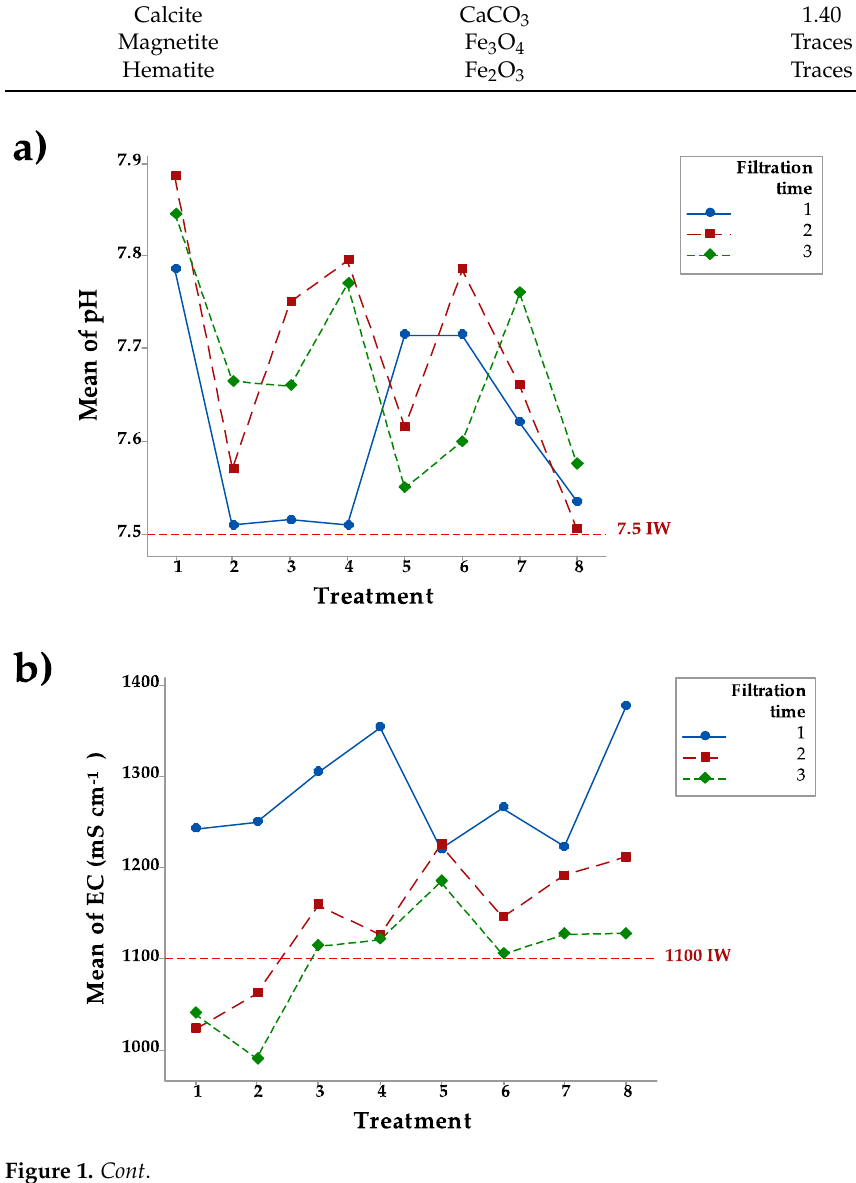
Figure 1. Levels of pH ( a ), EC ( b ), and TDS ( c ) in the eight treatments and three filtrations. 3.2. Leaching Na + , K + , Mg +2 , and Ca +2 Cations Na + levels in the IW were 148 ppm on average, meaning that this water could be used for irrigation. Figure 2a shows that after the first filtration, Na + ranged from 209 ppm in